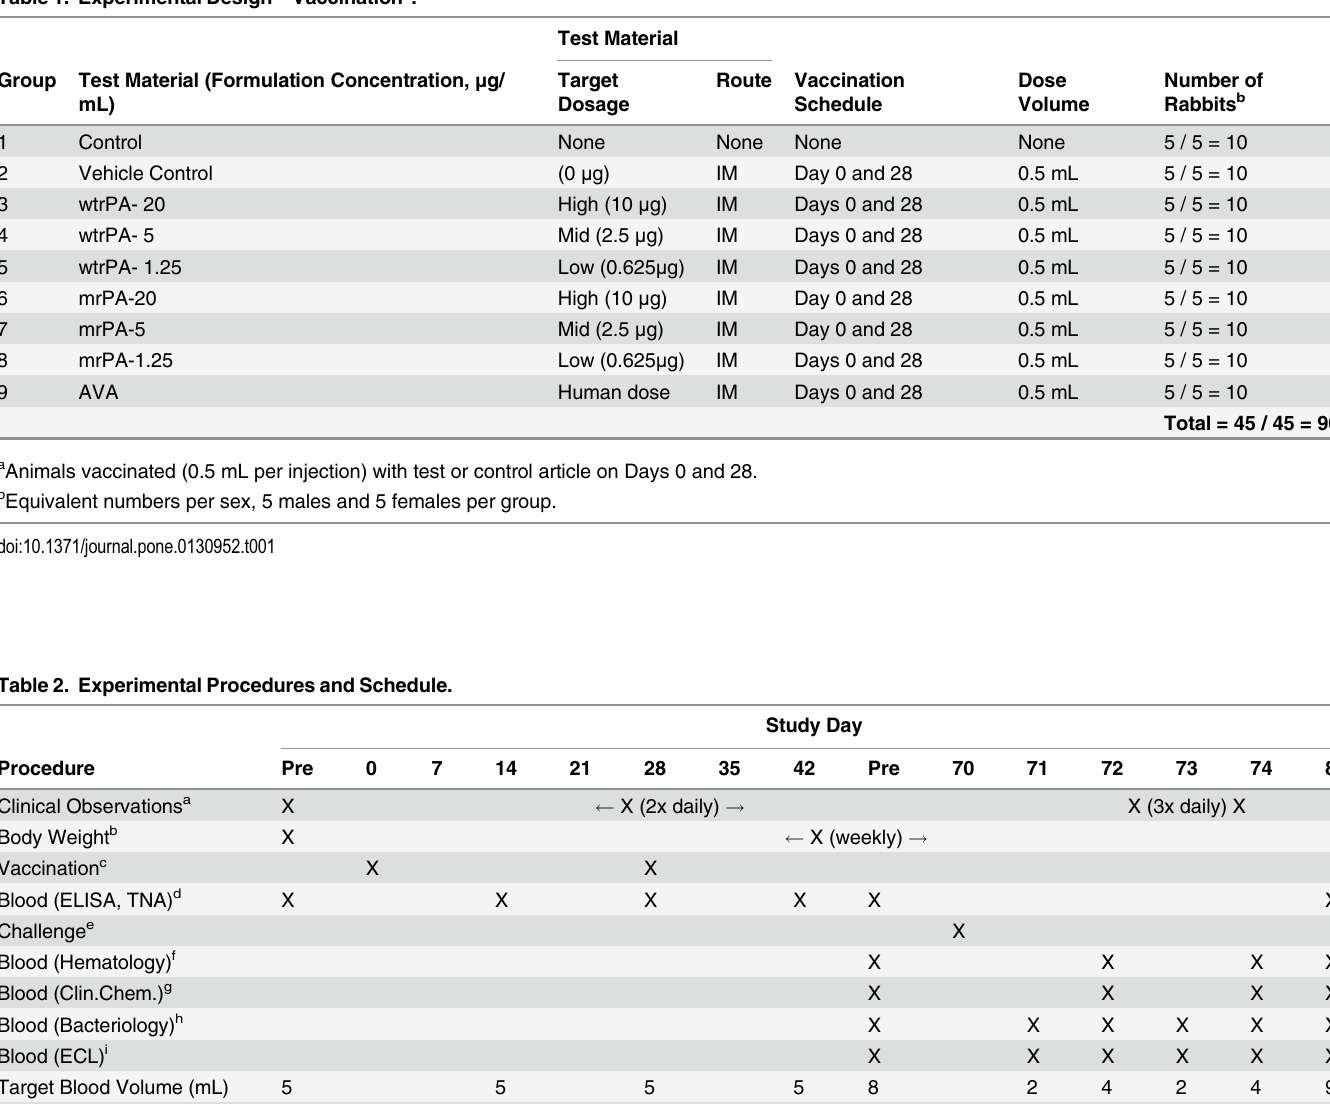
Table 1. Experimental Design — Vaccination a .